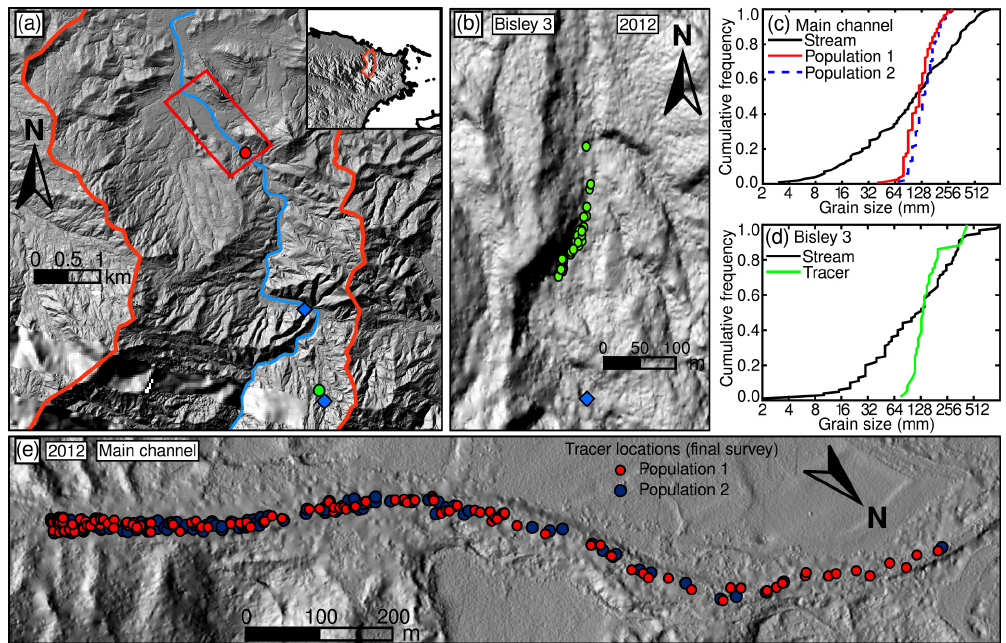
Figure 1. (a) DEM of northeastern Puerto Rico (inset) with Mameyes watershed outlined in red. The red and green circles represent the approximate starting locations of tracer particles in the main channel and headwaters stream (Bisley 3), respectively. Blue diamonds represent USGS and USFS stream gages. The blue line is the main channel of the Mameyes River; flow is from south to north. The red bounding rectangle represents the area in panel (e) . (b) Close-up map of the headwaters stream showing the location of the tracer particles (green circles) at the time of the final survey. (c) Grain size distributions for the main channel site determined by Wolman pebble count for the channel (black line), initial population of tracers (red line), and second population of tracers (blue dashed line). (d) Grain size distributions for the headwaters site determined by Wolman pebble count for the channel (black line), and population of tracers (green line). (e) Close-up map of the main channel field site showing the locations of the first (red circles) and second (blue circles) populations of tracer particles at the time of the final survey. Flow direction is from left to